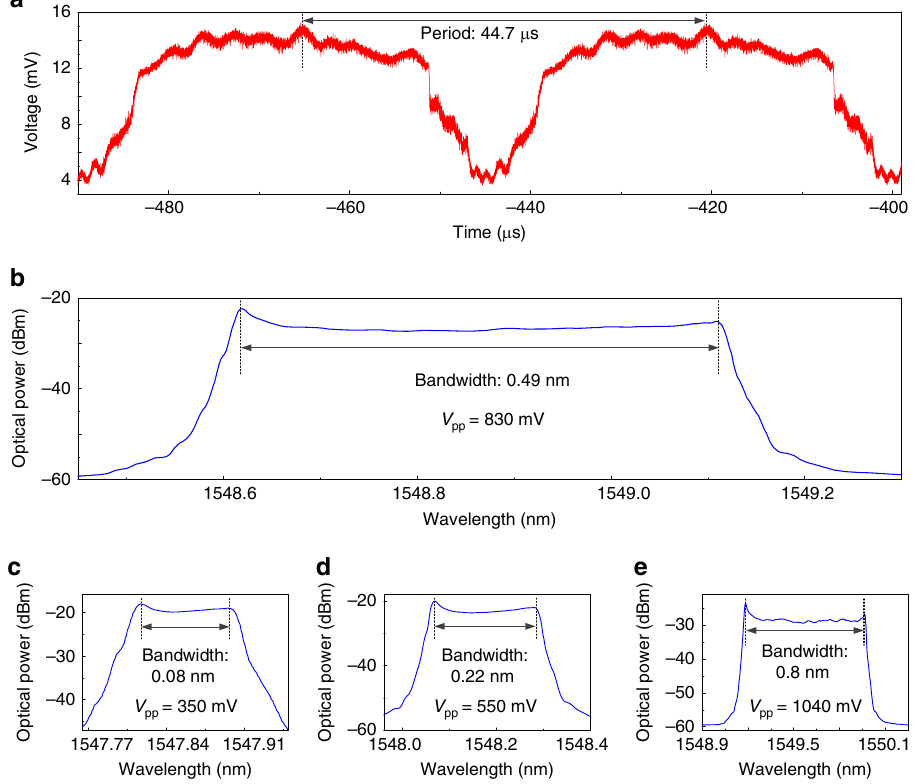
Fig. 3 Frequency-chirped optical pulse generated by the Fourier-domain mode-locked (FDML) laser. a Temporal pro fi le and b optical spectrum of the frequency-chirped optical pulse from the FDML laser when the bias voltage V PP applied to the micro-heater is 830 mV. The optical spectrum of the frequency-chirped optical pulse from the FDML when the bias voltages V PP applied to the micro-heater are c 350 mV, d 550mV, and e 1040